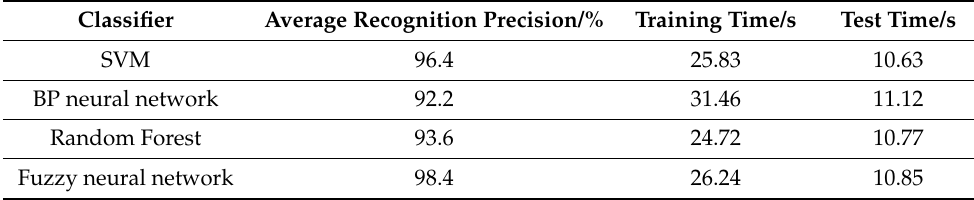
Table 8. Average recognition precision and calculation times of the four